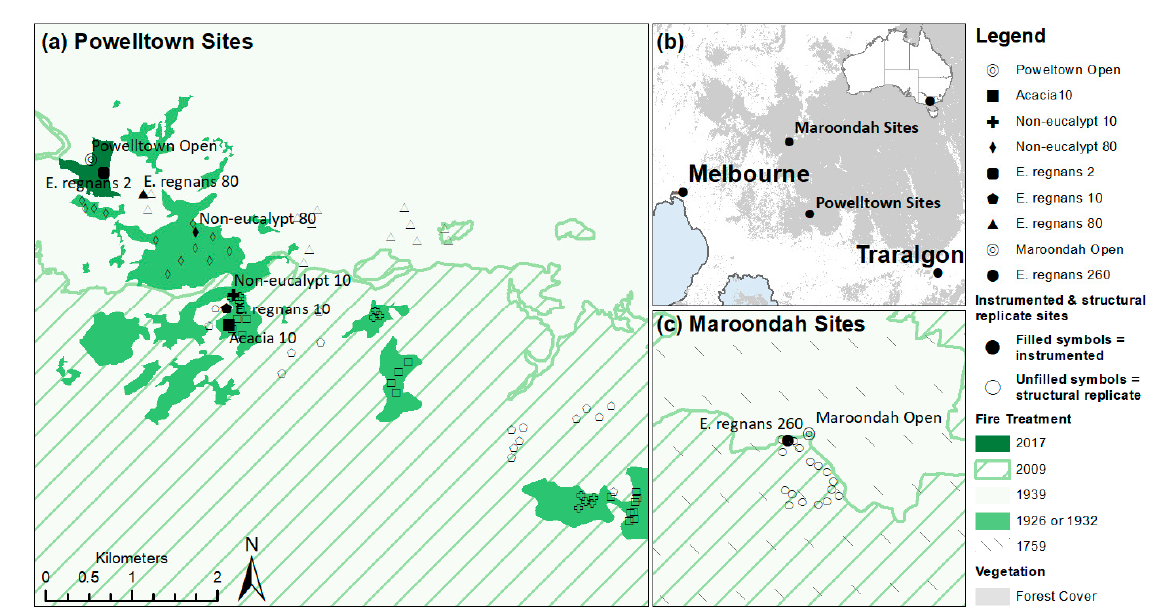
Figure 2. Location of the study areas, including seven instrumented field sites and two open (control) weather stations within the Central Highlands, Victoria, in southeastern Australia ( b ). Coloured and dashed areas indicate the fire disturbance conditions, denoting the most recent fires affecting forest structure at the alternative state forest sites. The 1939 fire (light green) affected the entire Powelltown ( a ) and Maroondah ( c ) regions. Table 1. Site information of the instrumented plots and open-weather stations. Site data is located below the relevant open weather station (Powelltown Open & Maroondah Open).